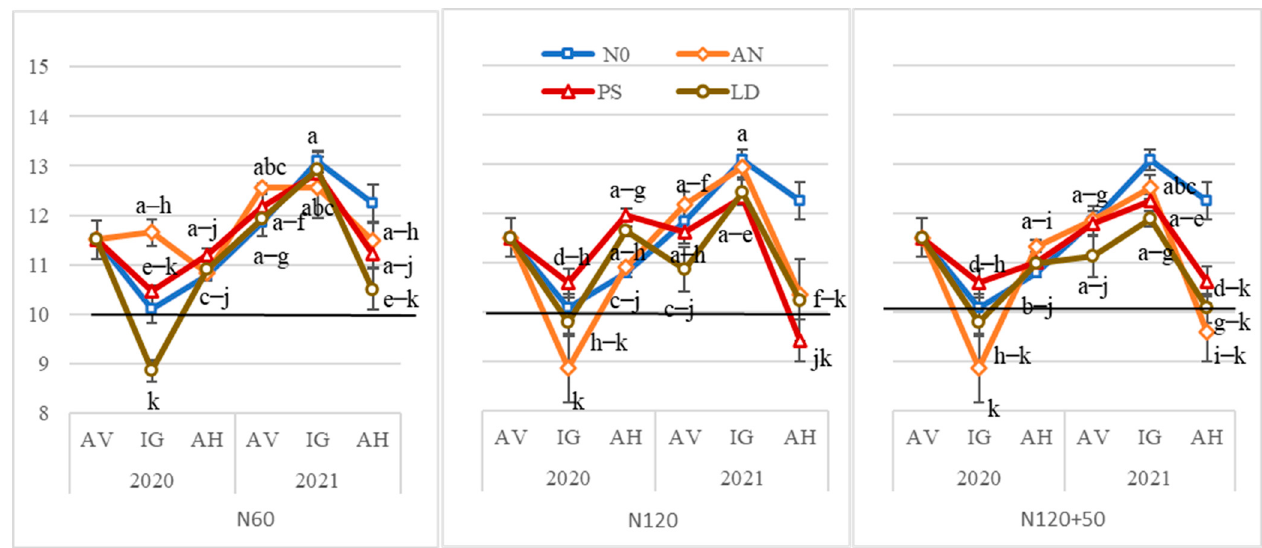
Figure 5. Variation of soil C:N ratio (0–30 cm) as influenced by winter wheat growing season, different nitrogen rates, and fertilizer interactions. The standard error ( SE ) of the mean is used to represent error bars. Means with different letters within interaction are significantly different at the p < 0.05 level (N0 and AV2020 values were not included in the calculations; the letters are only implied). Abbreviations. Soil collection time: AV, at the beginning of winter wheat vegetation; IG, during intensive winter wheat growing (~1.5 months after AV and fertilization); AH, after winter wheat harvest. Fertilizers: N0, unfertilized; AN, ammonium nitrate; PS, pig slurry; LD, liquid anaerobic digestate. Nitrogen (N) rates: N60, 60 kg N·ha − 1 rate; N120, 120 kg N·ha − 1 rate; N120+50, 120 + 50 kg